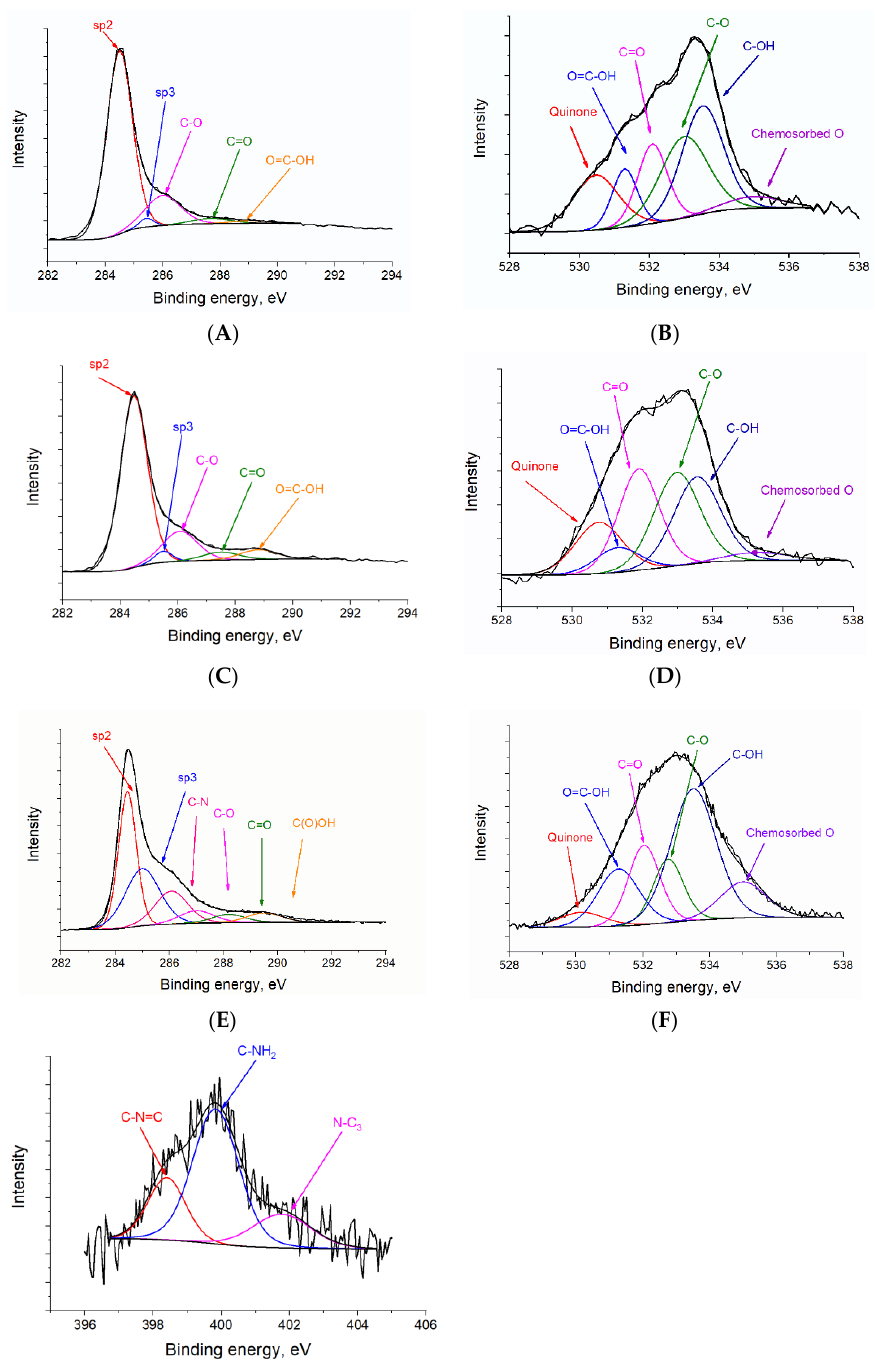
Figure 2. X-ray diffraction patterns for Pt 20 /C, Pt 20 /rGO, Pt 20 /rGO-O and Pt 20 /rGO-Am. The elemental composition of Pt 20 /rGO, Pt 20 /rGO-O and Pt 20 /rGO-Am catalysts was studied using X-ray photoelectron spectroscopy. According to the C 1 s spectra (Figure